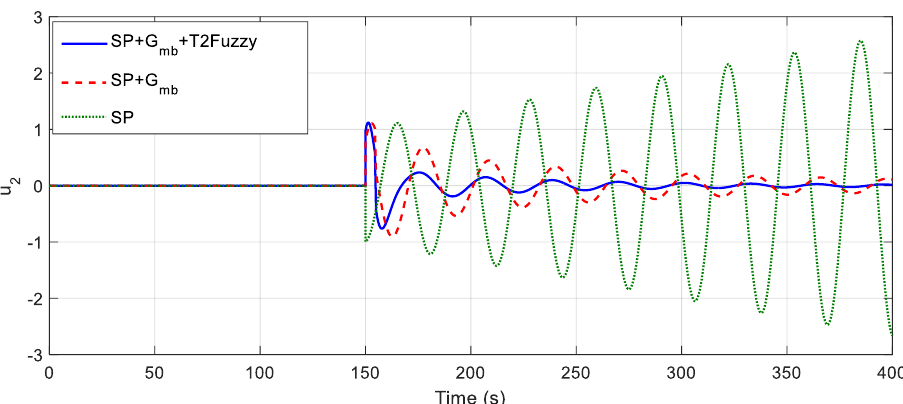
Figure 17. The control signal 𝑢 1 for all three methods by applying uncertainty.